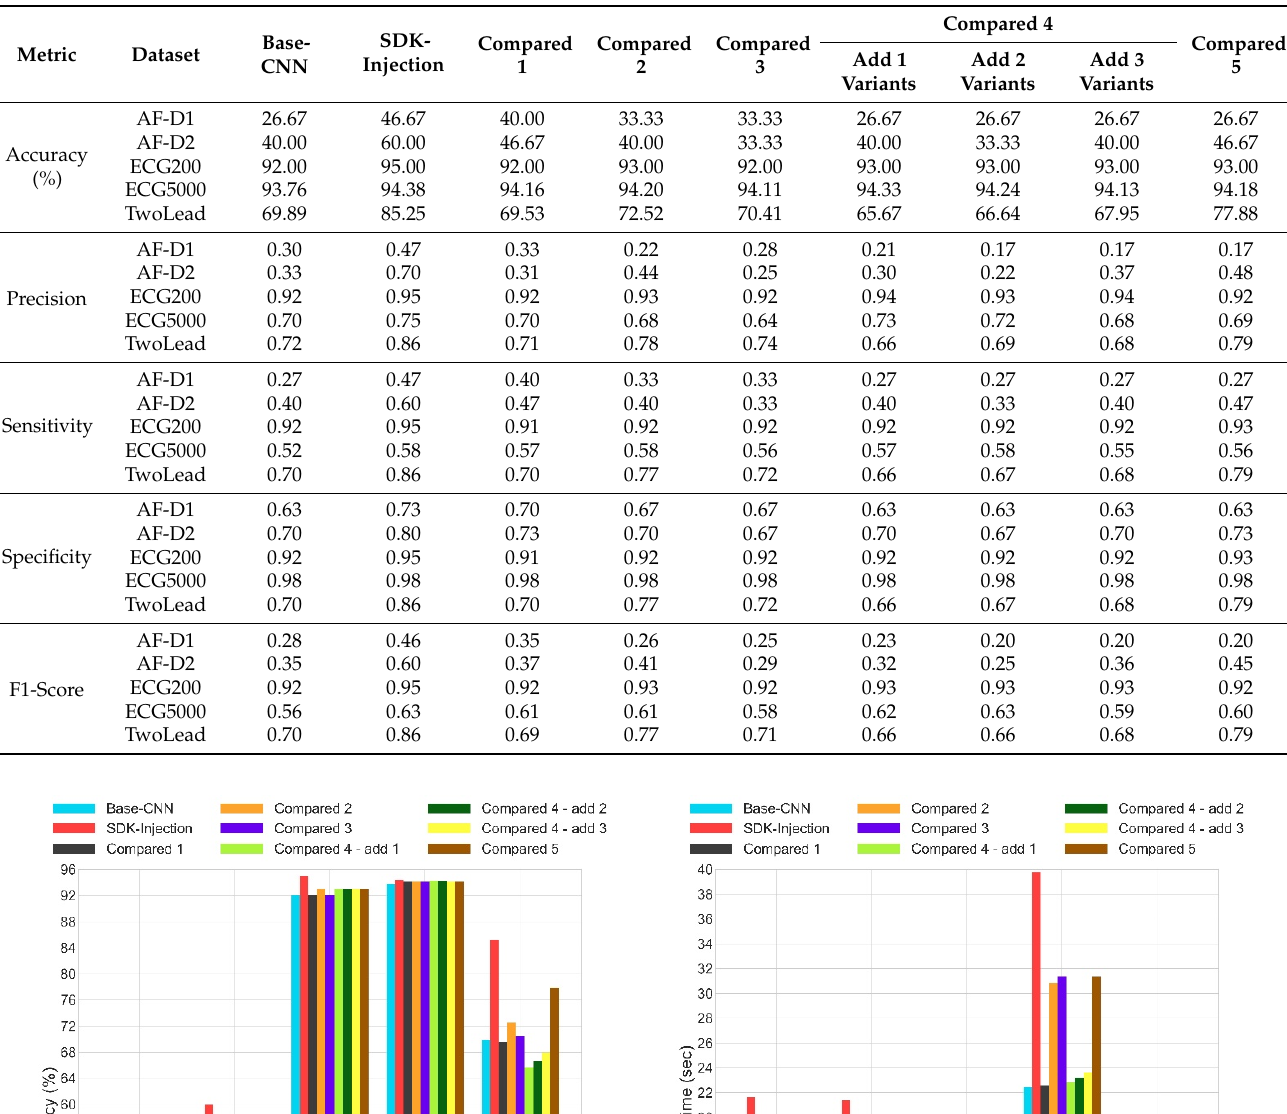
Table 6. Performance evaluation of Base-CNN, SDK-Injection, and other comparison methods.